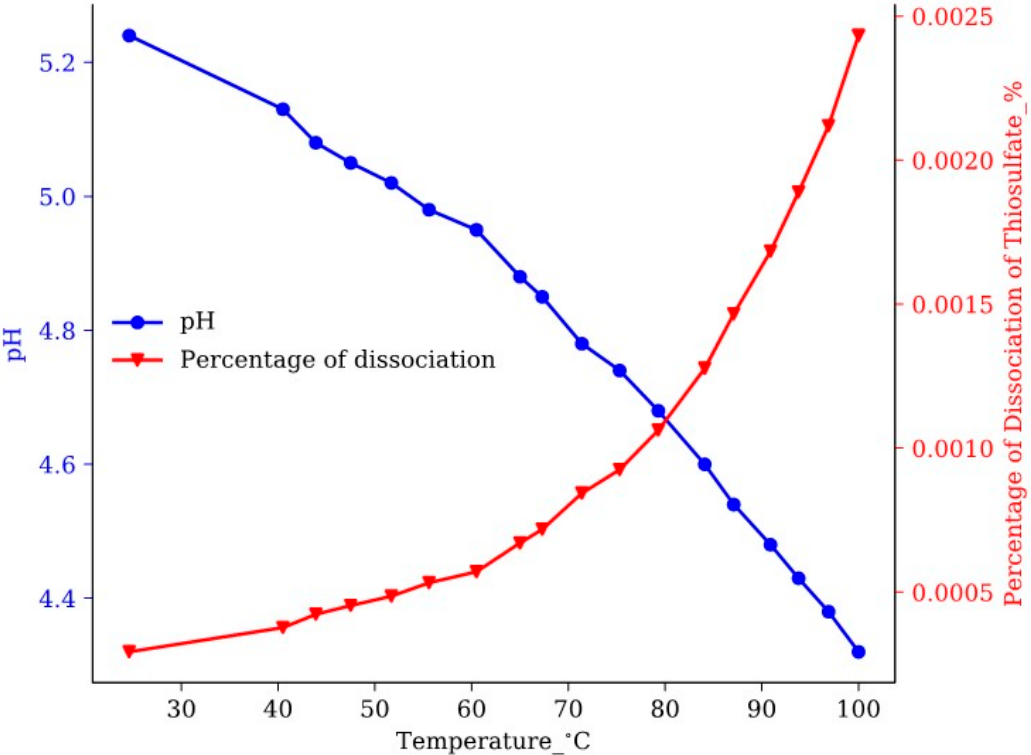
Figure 6. Dissociation of ammonium thiosulfate versus the temperature.